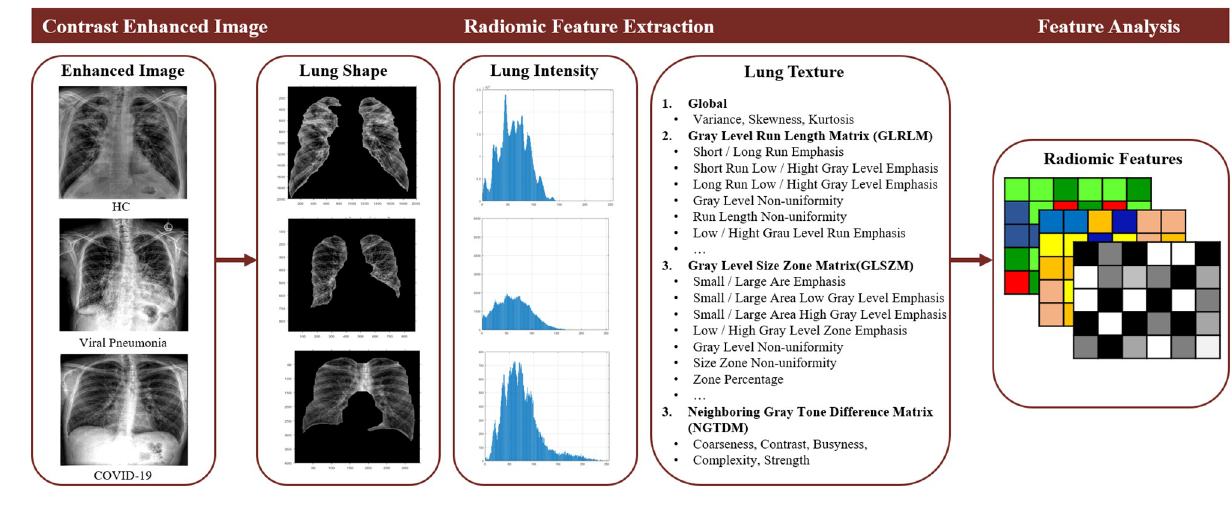
Fig 2. Flowchart of radiomic feature